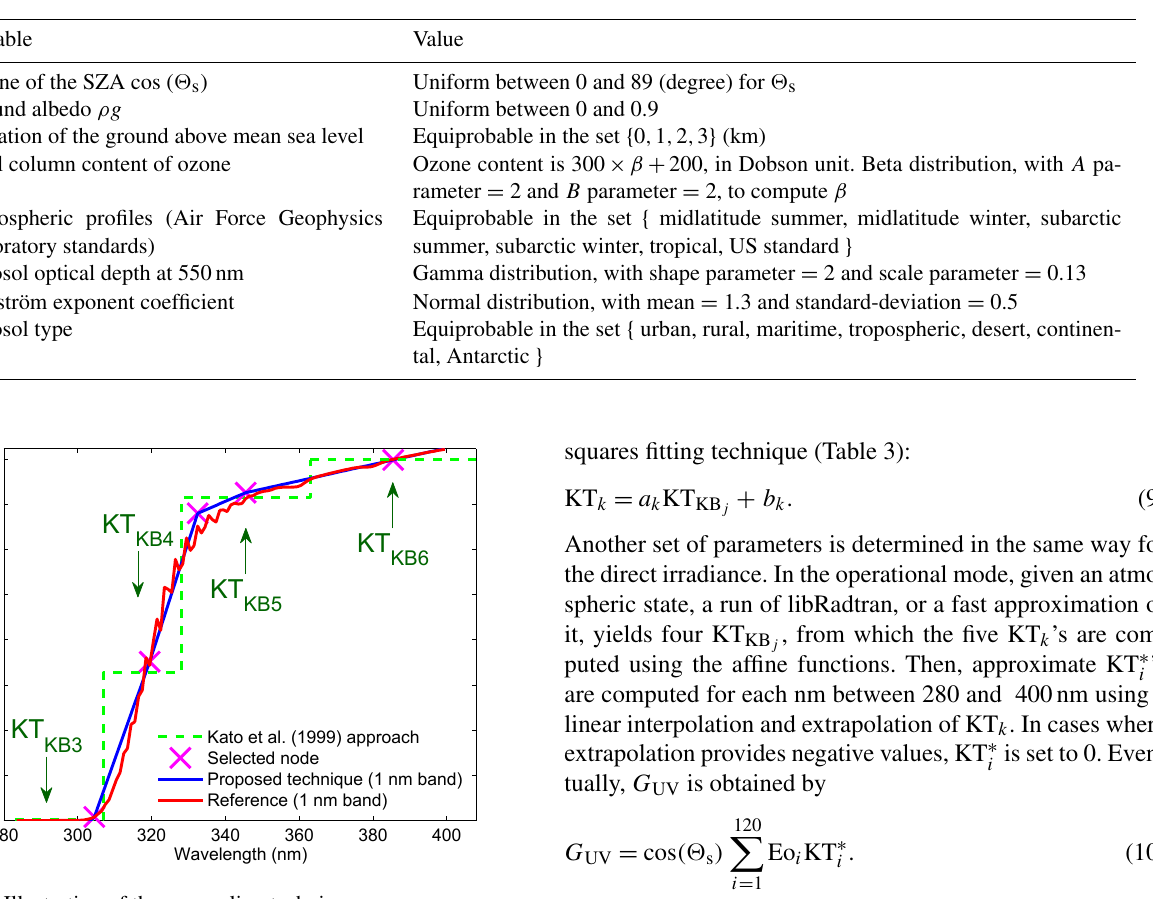
KT KB4 , KT KB5 and KT KB6 and (2) with detailed